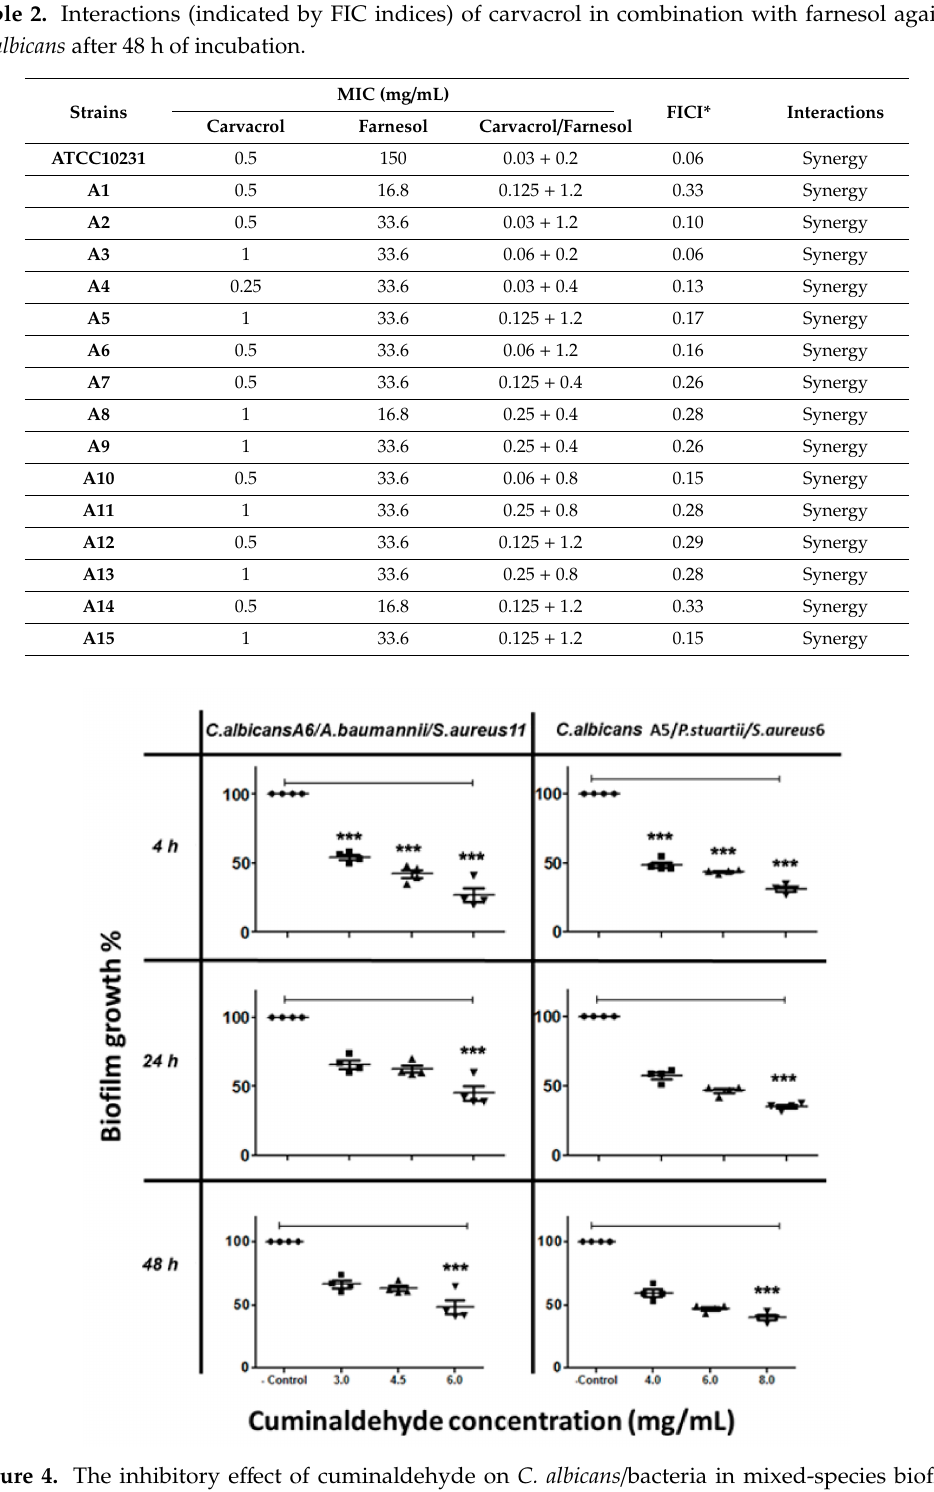
Figure 4. The inhibitory e ff ect of cuminaldehyde on C. albicans / bacteria in mixed-species biofilm at di ff erent time points, as determined by MTT reduction assays. C. albicans cells were allowed to adhere onto 96 well plates at di ff erent times (4 h, 24 h, and 48 h), followed by treatment with